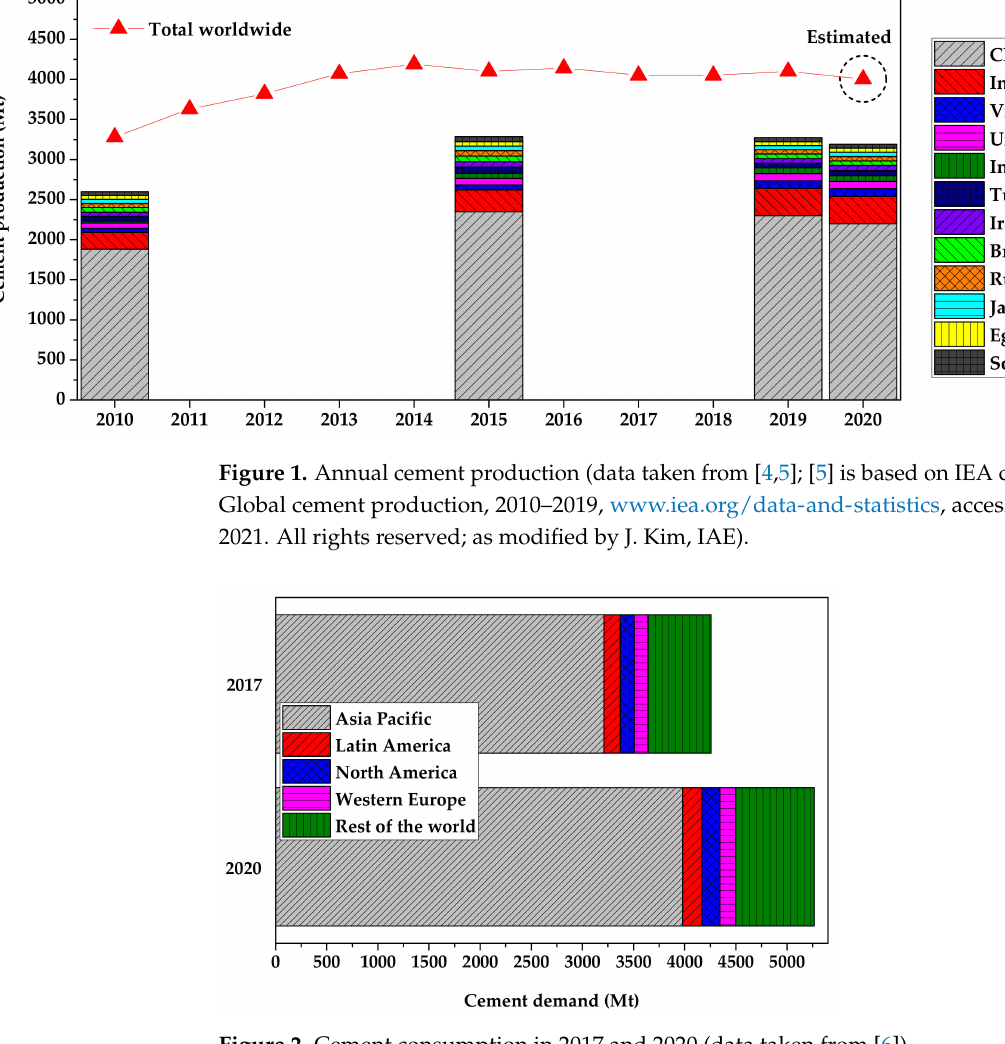
Figure 2. Cement consumption in 2017 and 2020 (data taken from